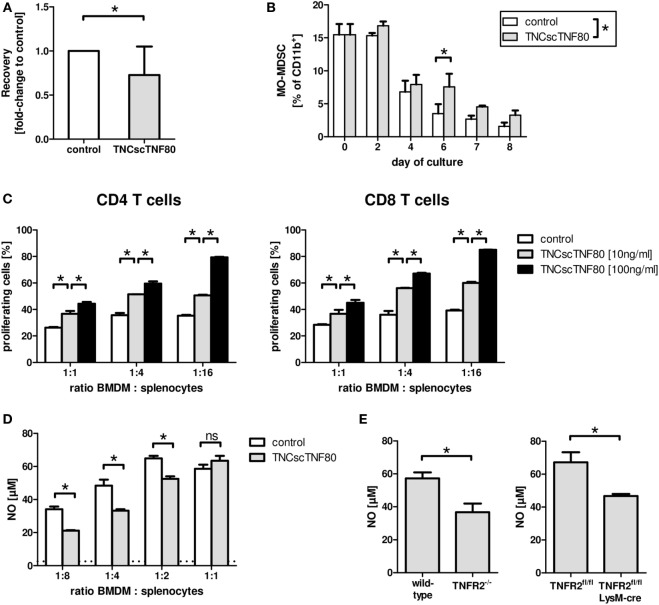
Effects of TNCscTNF80 on myeloid cells. The cell yield of bone marrow-derived myeloid cells was determined after 7 days of culture in the presence of GM-CSF with or without TNCscTNF80 (10 ng/ml). Data of 10 experiments are shown as mean + SD of the normalized values. (A) The percentage of immature MO-MDSC (Ly6G−Ly6Chigh) in cultures of bone marrow-derived myeloid cells with or without TNCscTNF80 (10 ng/ml) at the indicated time points is shown. Data shown as mean + SD of four mice from one experiment (B). Suppressive activity of graded numbers of bone marrow-derived myeloid cells (BMDM) generated over 6 days in the presence or absence of TNCscTNF80 (10 and 100 ng/ml) was measured. Proliferation of CD4 (left) and CD8 T (right) cells was determined by cytometry (C). The concentration of generated nitrite in supernatants of these cultures (containing 100 ng/ml of TNCscTNF80) was determined. The horizontal dotted line indicates the background NO levels of splenocytes cultured without additional BMDM. Data from one experiment are shown (D). Bone marrow-derived myeloid cells from the indicated mouse lines were generated over 8 days, and the capacity to produce nitrite following stimulation with LPS and IFNγ was determined. Data shown as mean + SD of four mice from one experiment (E).